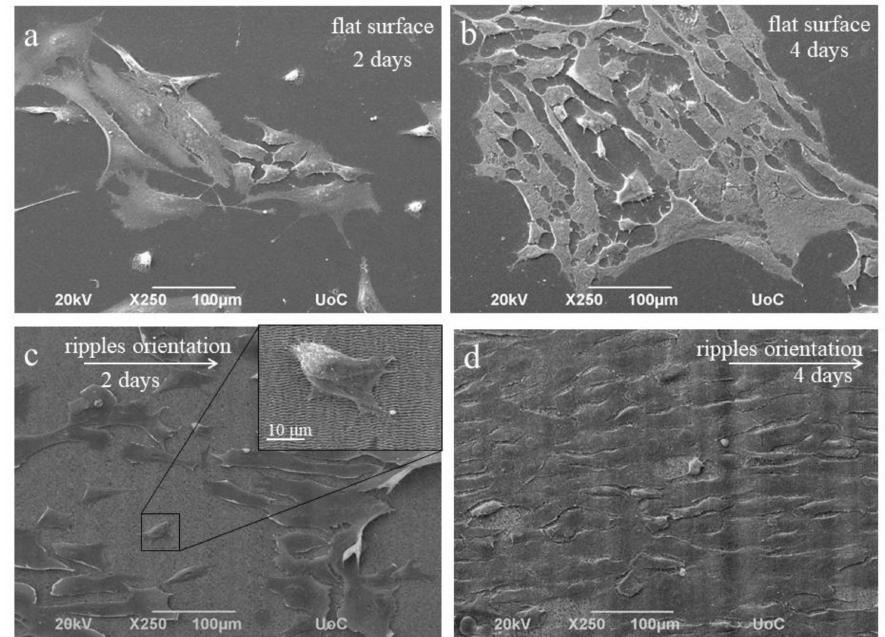
Figure 7. SEM images of NIH 3T3 fibroblasts cultivated on the as-deposited ( a , b ), and laser-processed 15 × (Ti / Zr) / Si multilayer thin film ( c , d ), for 2 and 4 days,